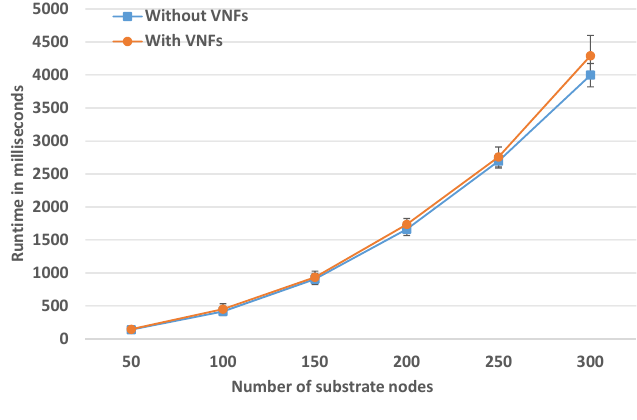
Figure 9. Runtime for increased SN